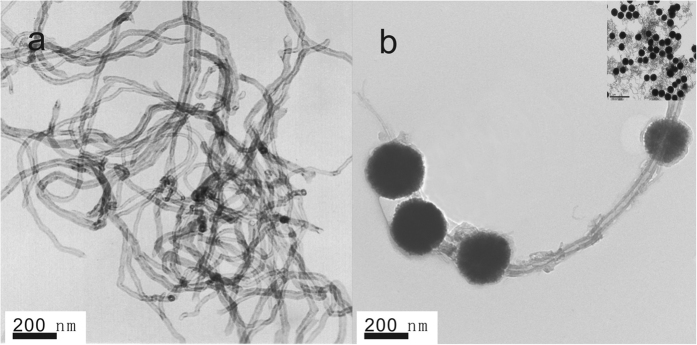
TEM images of (a) MWCNTs and (b) MWNTs-Fe3O4. Inset: The TEM image of MWNTs-Fe3O4 with 1 μm scale.